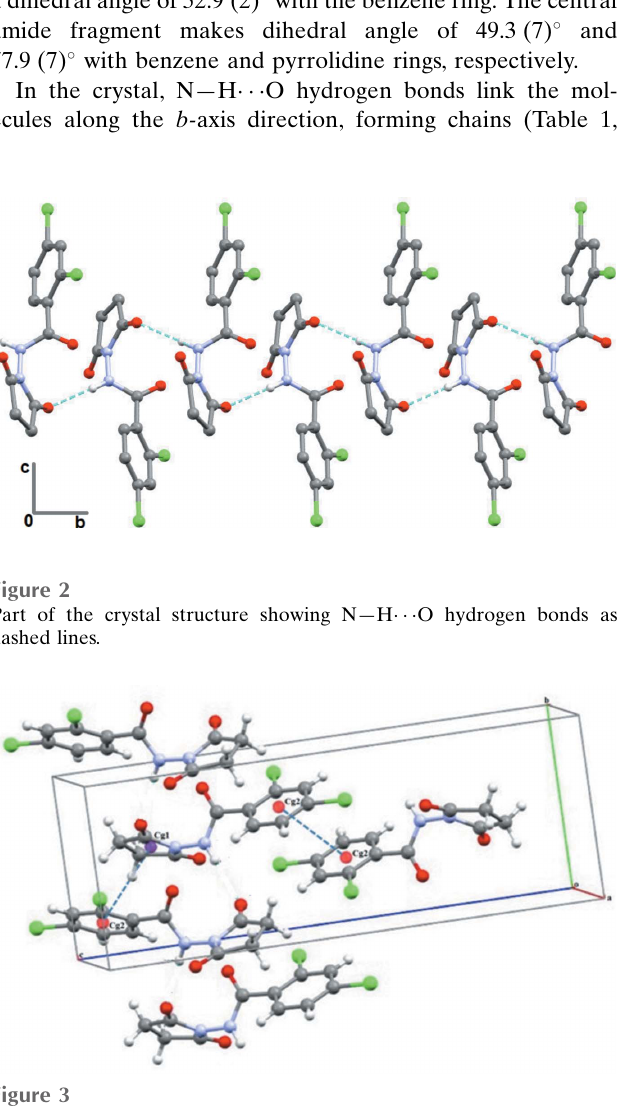
Figure 3 Part of the crystal structure showing the (cid:2) – (cid:2) stacking interactions.